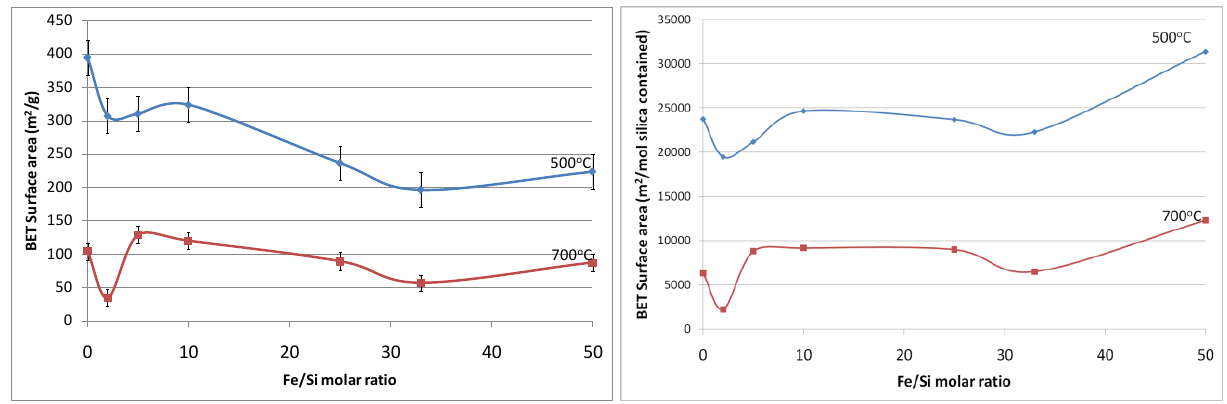
Figure 5. ( a-left ) Surface area of samples; and ( b-right ) surface area per mole of silica, as a function of Fe/Si molar